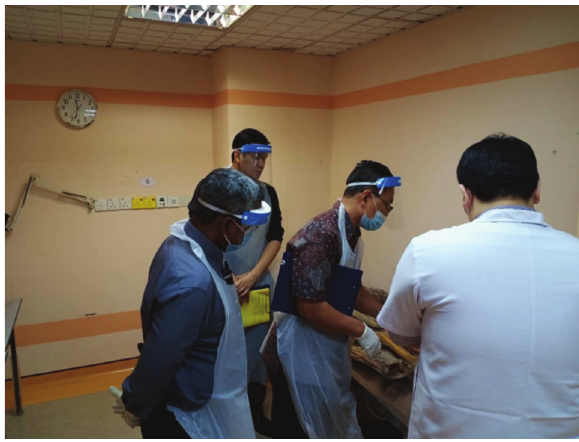
Viva sessions conducted in a large room. Fig. 3: